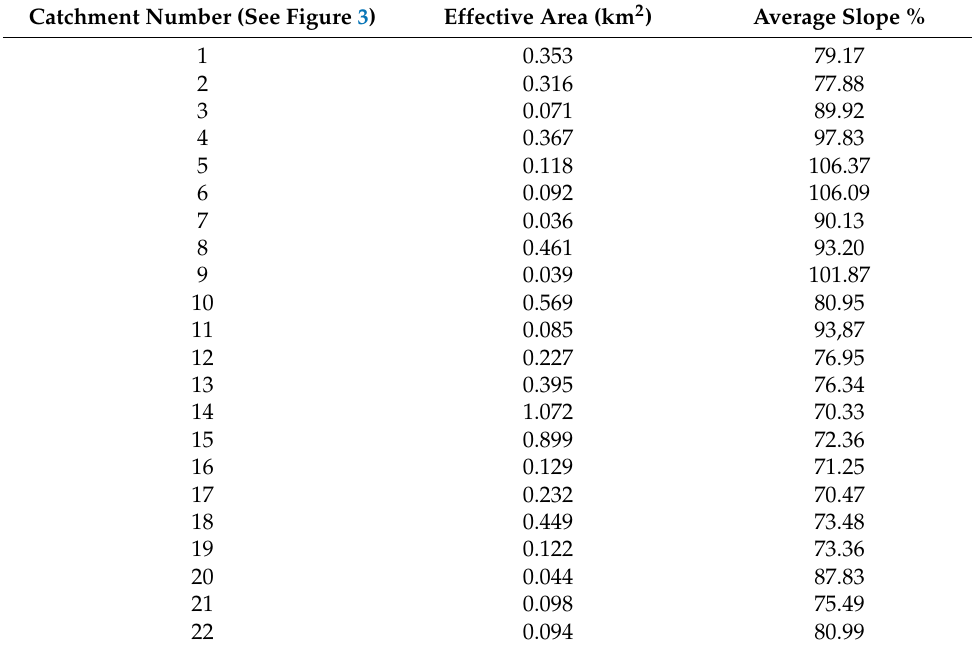
Table 3. Morphometric parameters of the subcatchment of the Ischiator basin. Catchment Number (See Figure 3) Effective Area (km 2